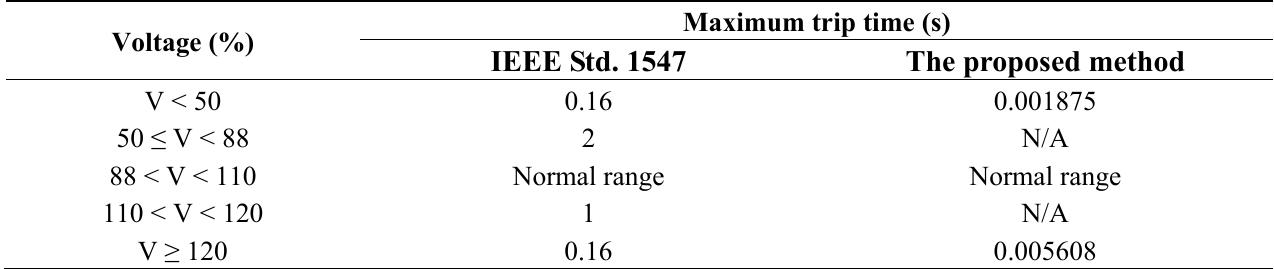
Table 1. The IEEE Std. 1547 and specifications of the proposed method for islanding voltage detection.